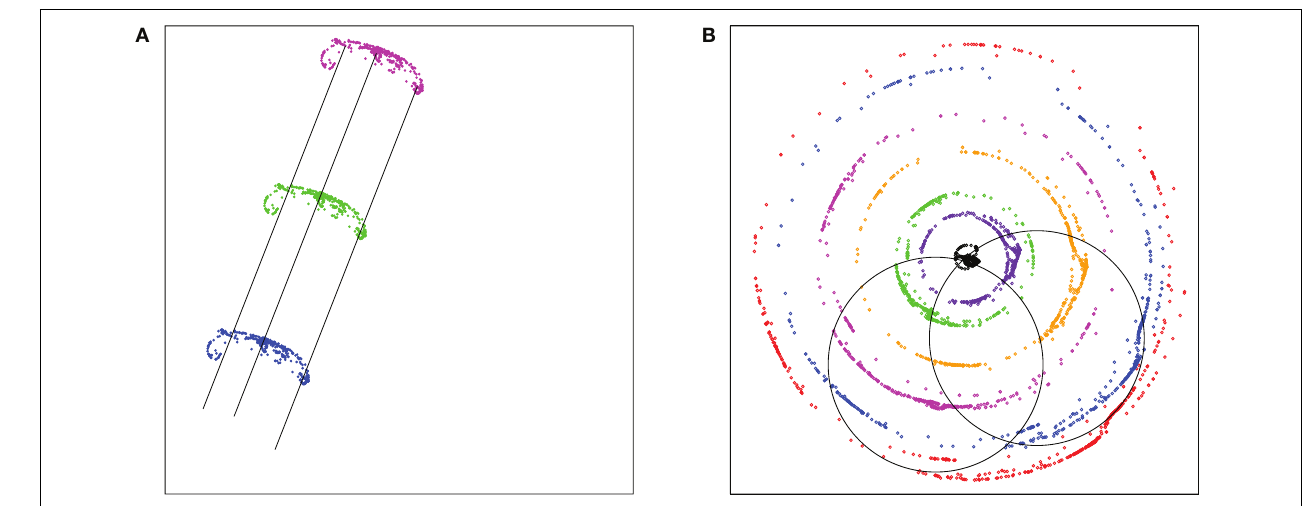
units. (B) Cyclic state: the stationary state pulsating flock has been shown at different time instants: 173,000 (black), 176,000 (red), 180,000 (green), 188,000 (blue), 192,000 (brown), 197,000 (violet), and 200,000 (magenta). The time period is 28,835. Two individual agents’ circular trajectories with radius ≈ 137.67 are also shown. The frame size is 600 × 600